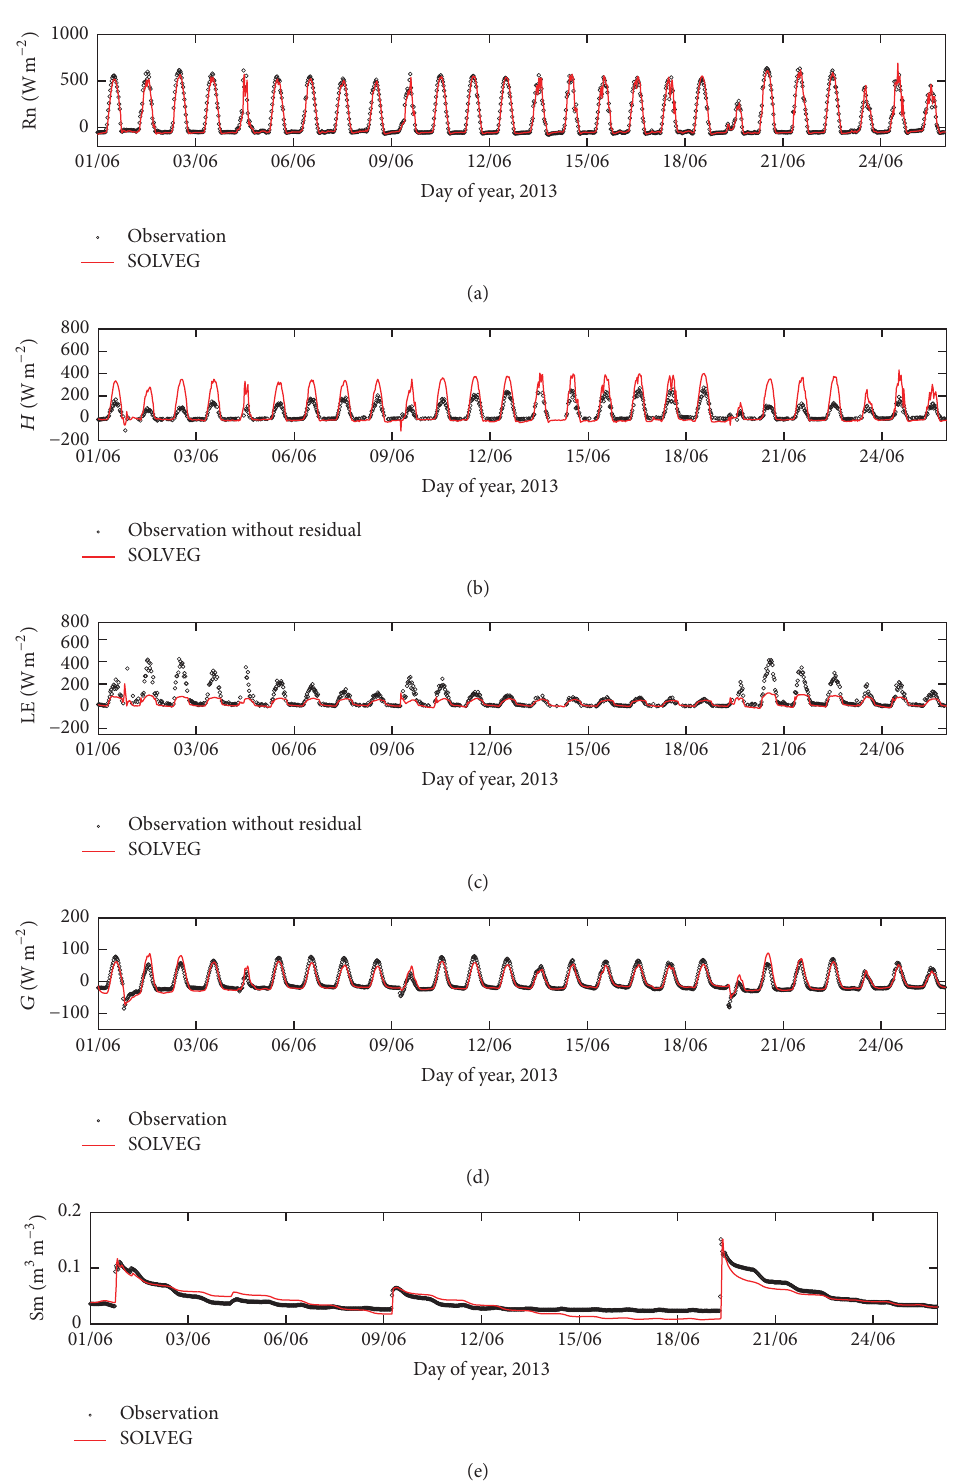
Figure 5: Temporal changes in (a) net radiation, (b) sensible heat flux, (c) latent heat flux, (d) ground heat flux, and (e) soil moisture content at a depth of 0.03 m at the study site during the wet